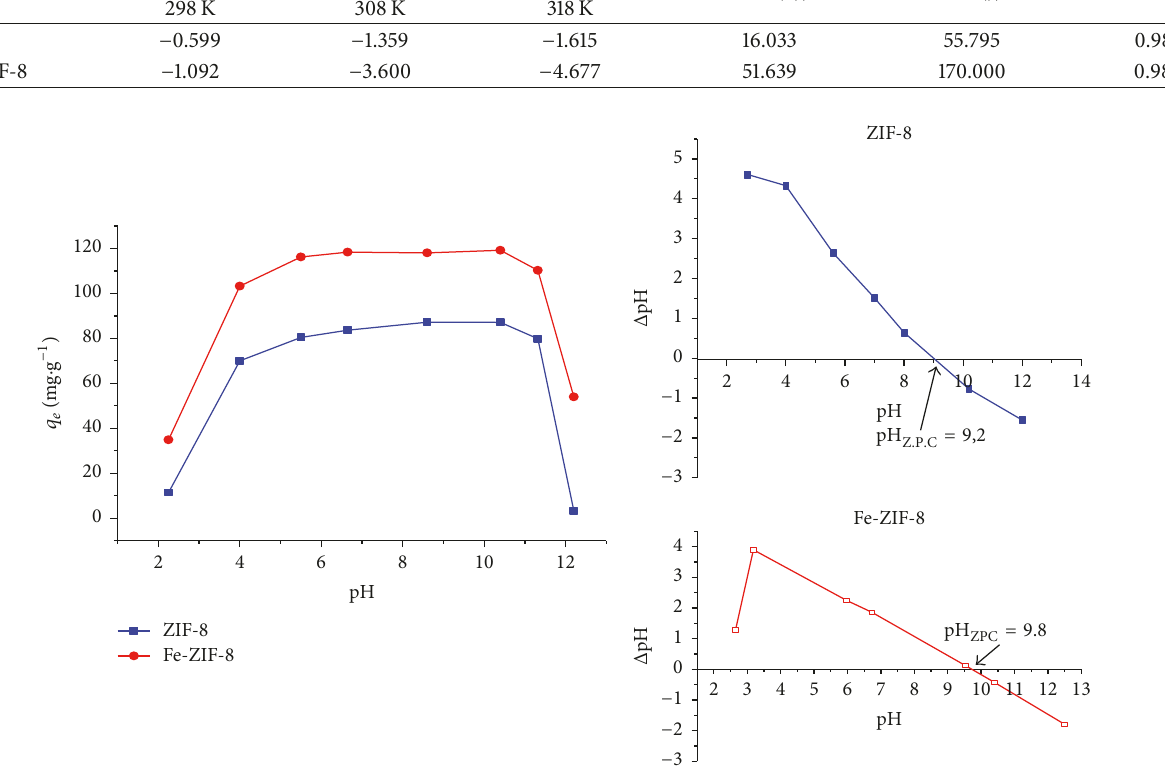
Figure 10: Effect of pH on the adsorption of RDB by ZIF-8 and Fe-ZIF-8 ( 𝐶 24 h; Temp. = 30 ∘